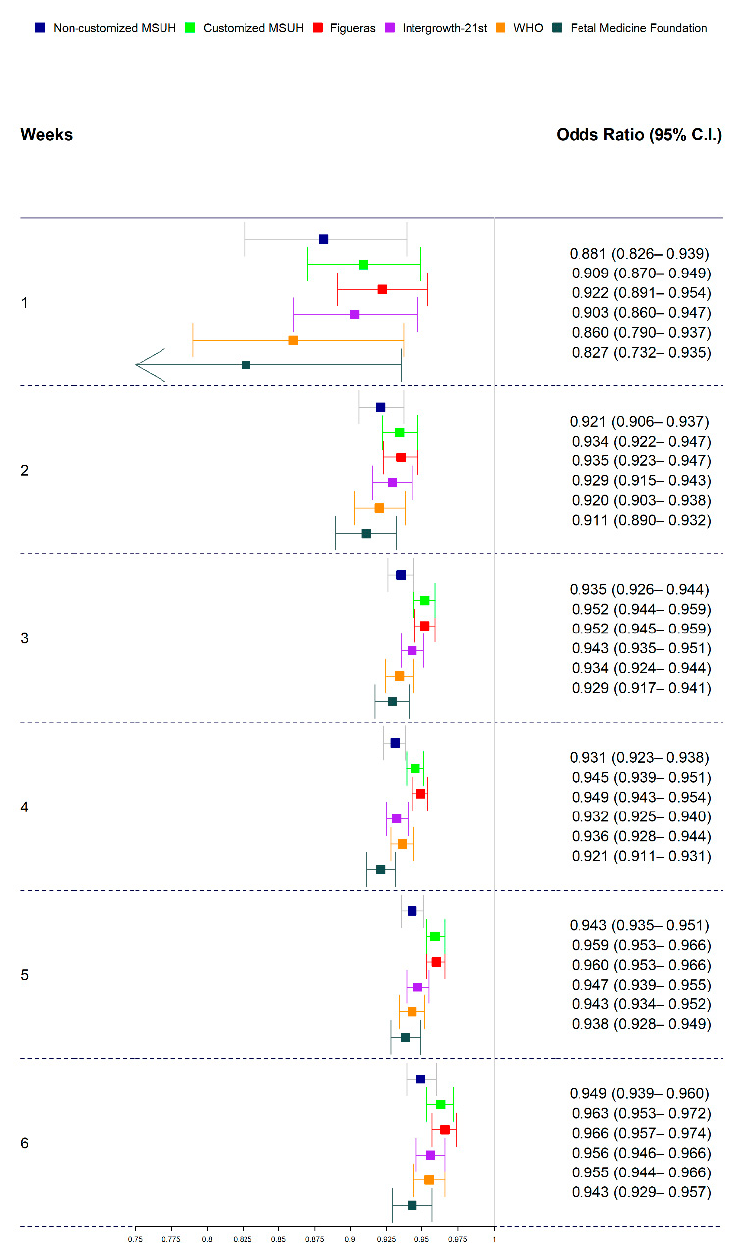
Figure 6. Odds ratios (ORs), 95% confidence intervals (CIs), and p- values of standards, in order to predict small for gestational age (SGA) fetuses by standard and ultrasound–delivery interval delivery date (1–6 weeks). Growth standards: non-customized Miguel Servet University Hospital (MSUH), customized MSUH, Figueras et al., INTERGROWTH-21st, World Health Organization (WHO), and Fetal Medicine Foundation.